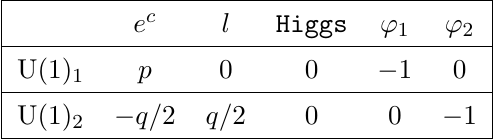
Table 2 . Charge assignement for a model invariant under U(1) 1 (cid:2) U(1) 2